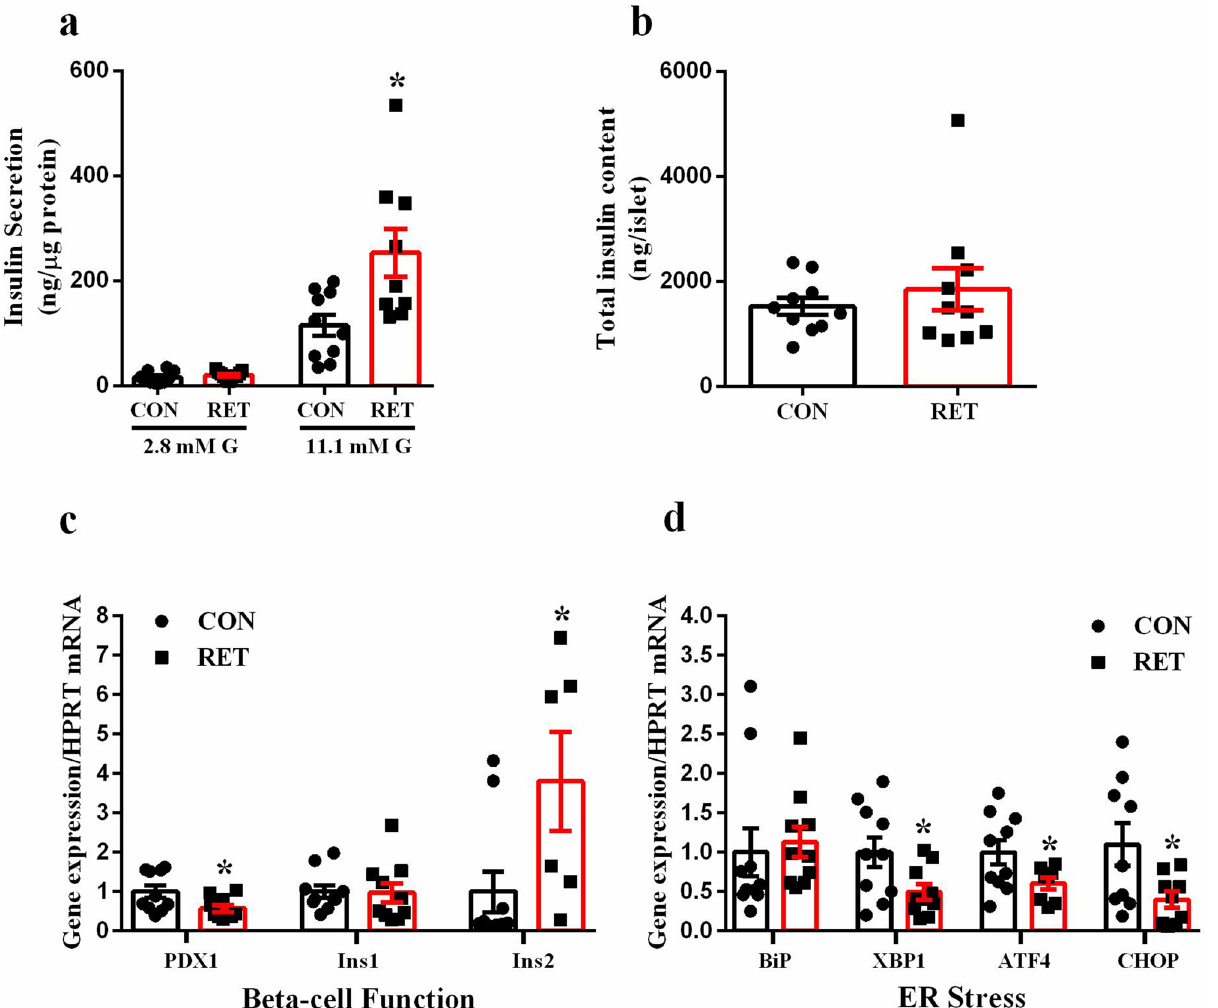
Figure 3. Resistance training increases glucose-stimulated insulin secretion and improves beta-cell function. Glucose-stimulated insulin secretion ( a ) and total insulin content ( b ) of islets from CON (black bar, n = 10) and RET (red bar, n = 9–11). Real-time PCR assay of PDX1, Ins1 and Ins2 mRNA levels ( c ) in pancreatic islets of CON (black bar, n = 10) and RET (red bar, n = 6–10). Real-time PCR assay of BiP, XBP1, ATF4 and CHOP mRNA levels ( d ) in pancreatic islets of CON (black bar, n = 9–10) and RET (red bar, n = 8–10). The relative expression of mRNAs was determined after normalization with HPRT. Data are the mean ± SEM. *P ≤ 0.05 (Student’s